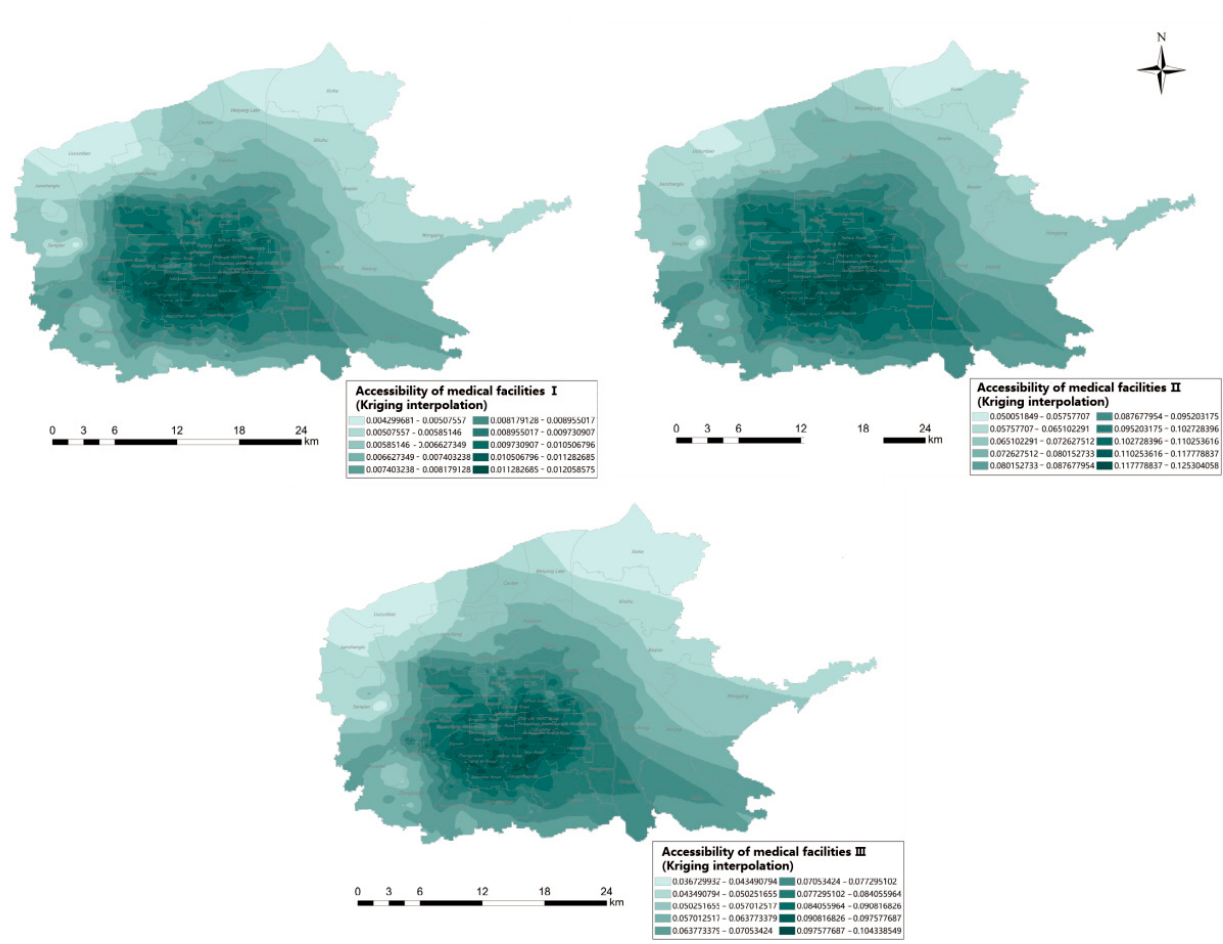
Figure 11. Comparison of accessibility. Table 4. Comparison of different models.